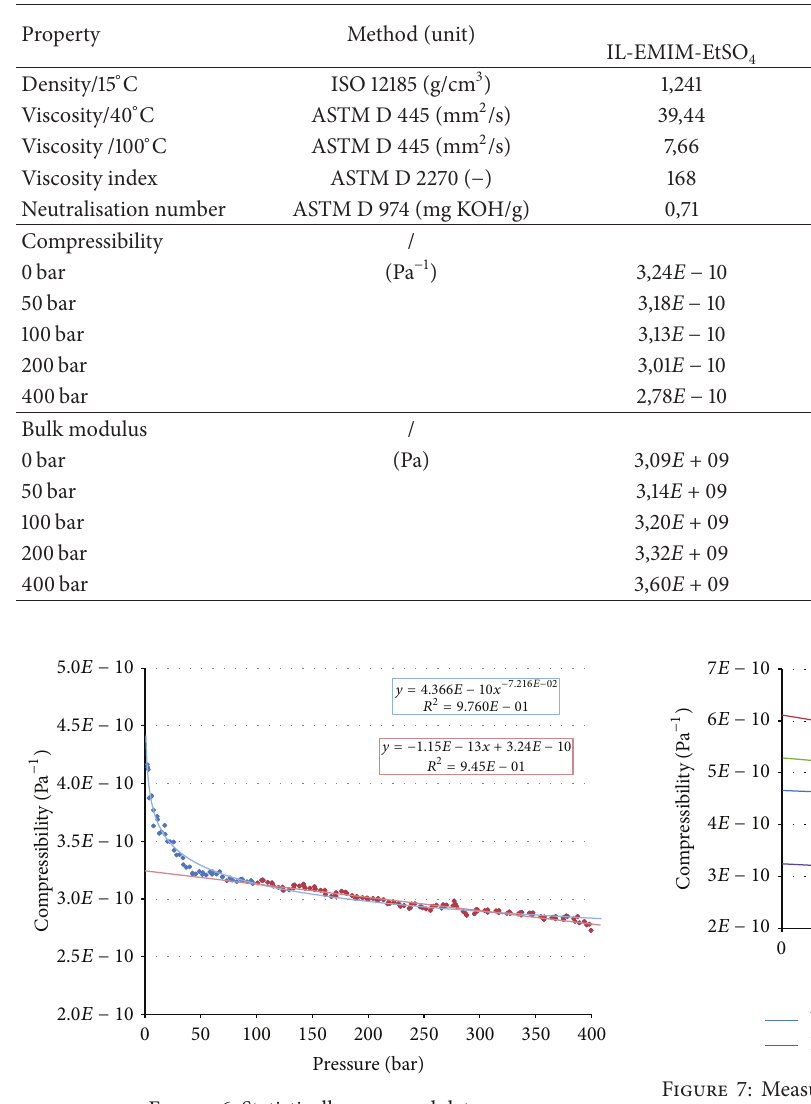
Figure 6: Statistically processed data.